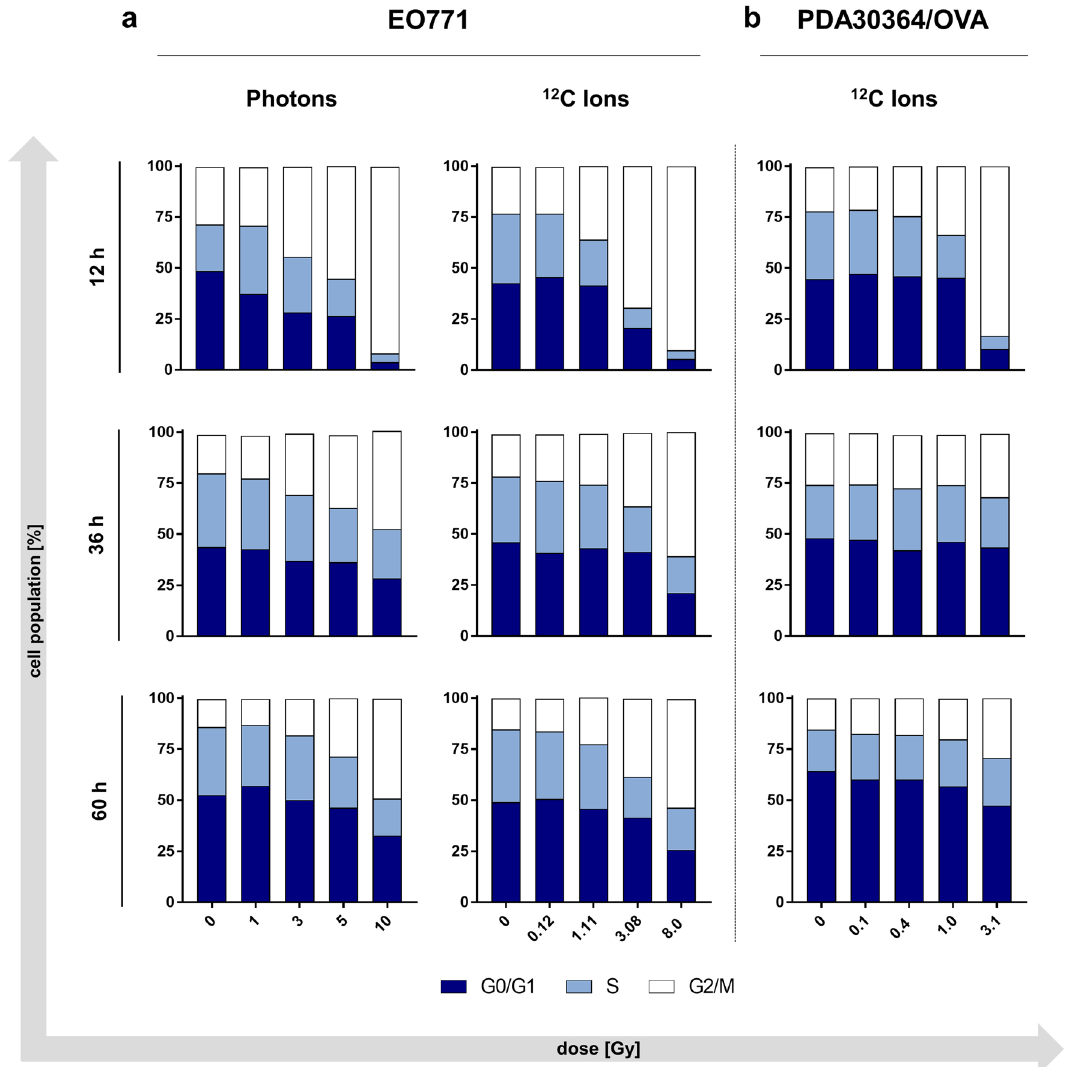
after irradiation with photons ( a , left and Ref. 25 ) or carbon ions ( a , right and b ) biologically equivalent to the indicated photon doses. DNA content was determined by propidium iodide staining followed by flow cytometric analysis. Representative results of one out of two independent experiments performed are